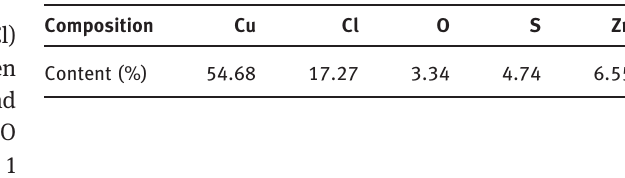
Table 2: The chemical elements of CuCl residue from zinc hydrometallurgy.